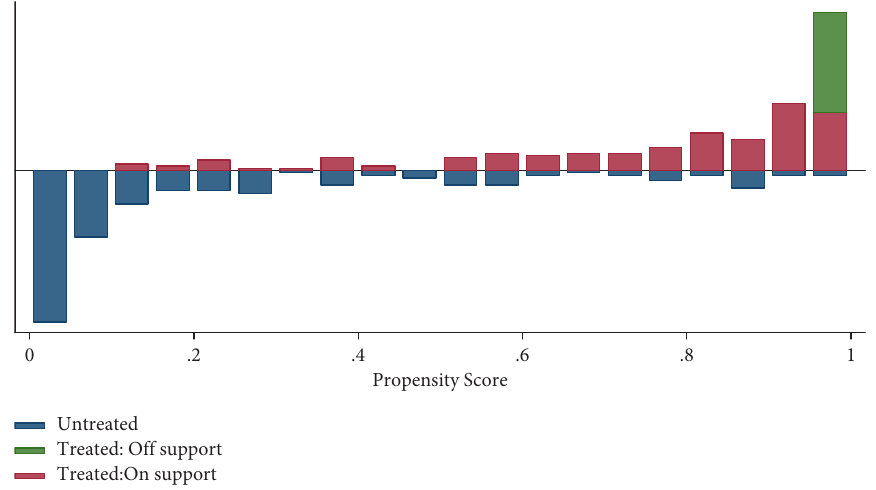
Figure 5: Distribution of propensity scores before the common region is imposed. Table 7: Propensity score distribution before selecting the common support region.